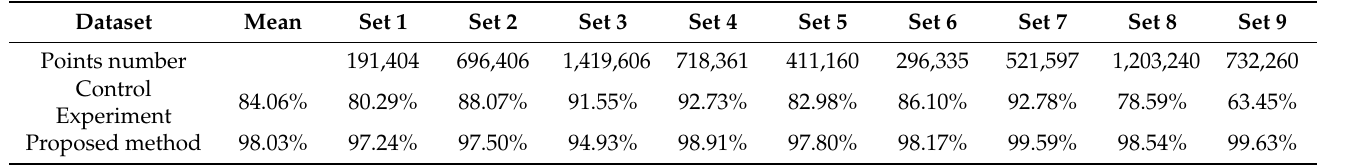
Table 2. Classification results for a large-scale dataset.